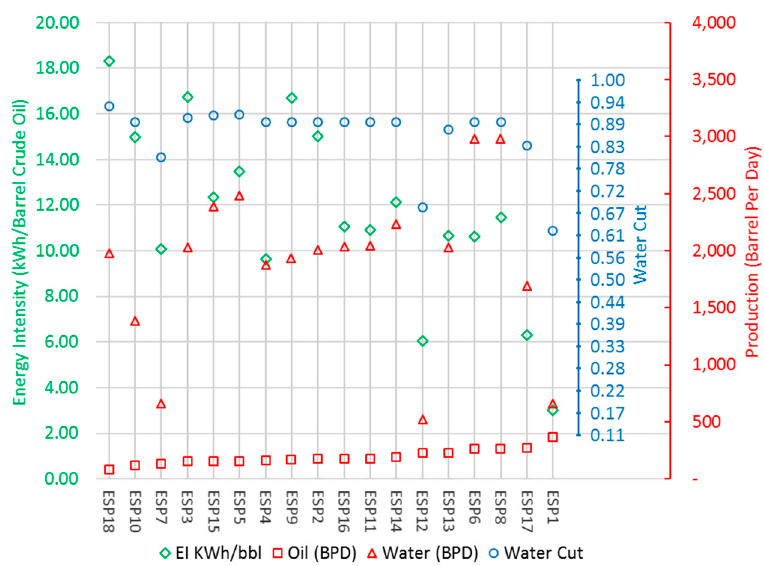
Figure 12. Water cut plotted against fuel costs.